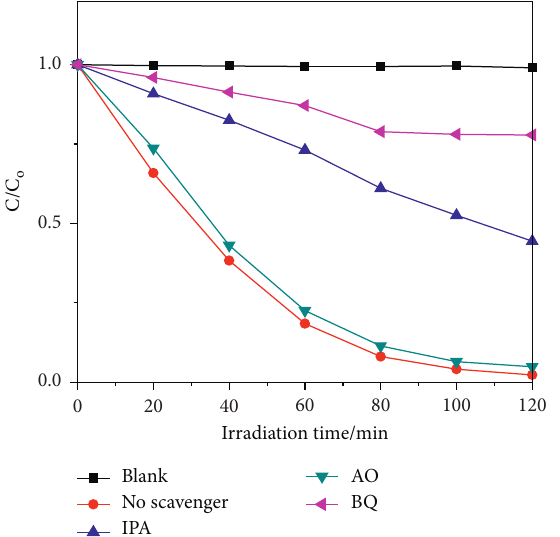
Figure 12: Photodegradation rate of MB after different scavengers were added.